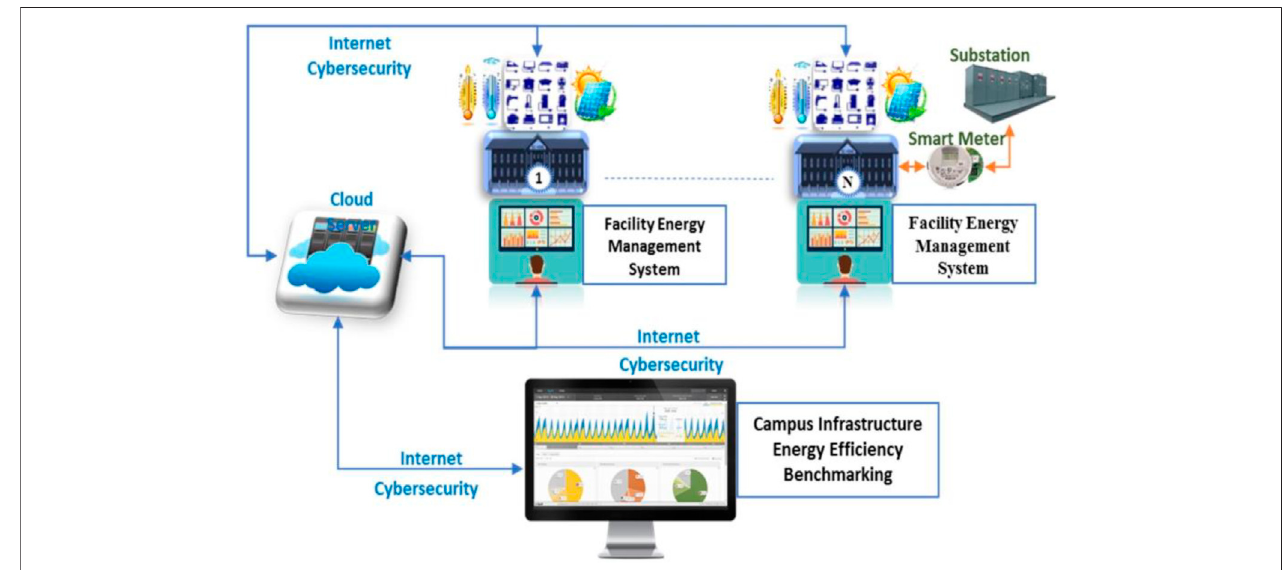
FIGURE 4 | Flow of information and system management in a smart